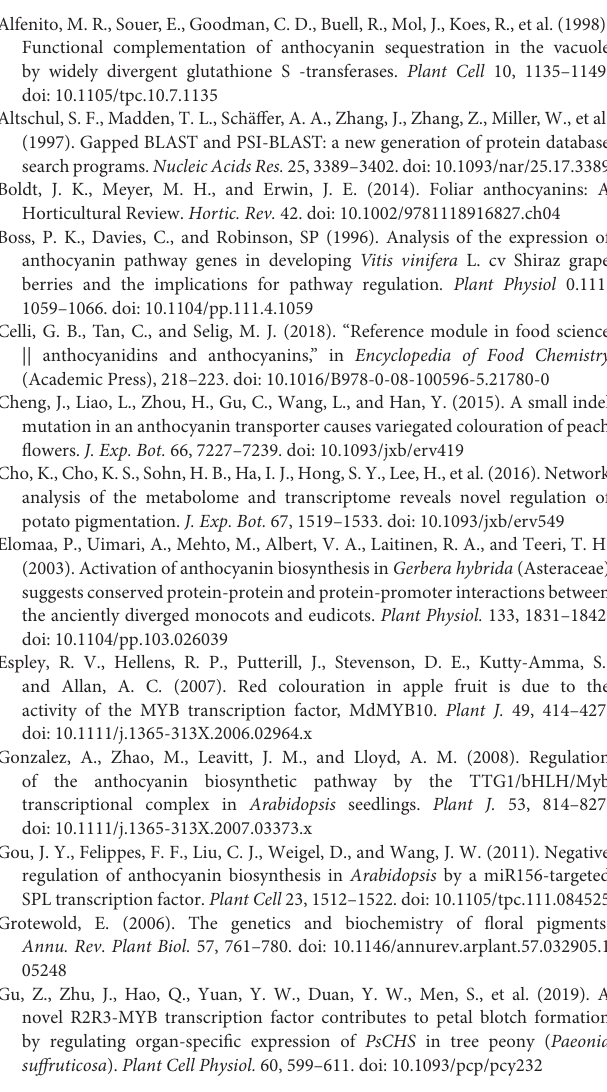
Supplementary Table S4 | Differentially expressed genes between WYY and FLE. Supplementary Table S5 | DEGs related to flavonoid transport. Supplementary Table S6 | DEGs related to sugar and hormones metabolism. Supplementary Table S7 | Differentially expressed transcription factors. Supplementary Table S8 | Primers used for